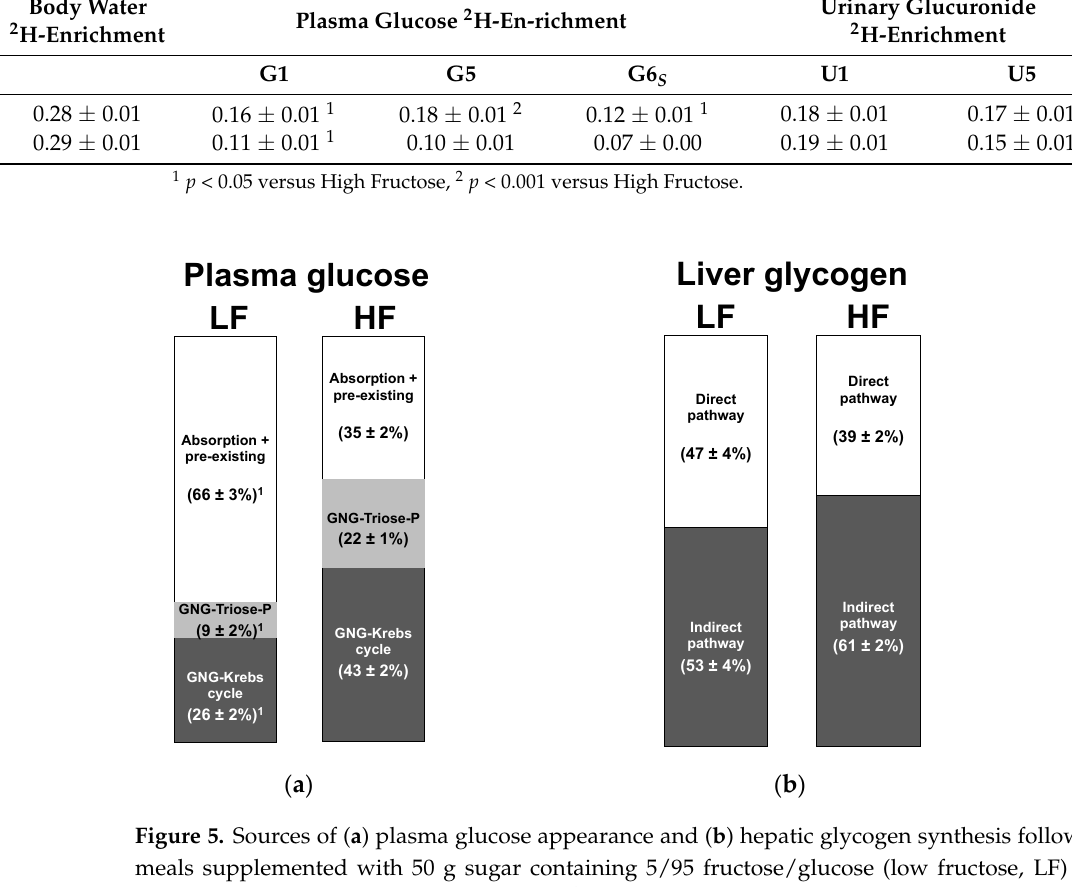
Table 2. 2 H-enrichment of body water, plasma glucose positions 1, 5 and 6S (G1, G5, G6 S ) and urinary glucuronide posi-